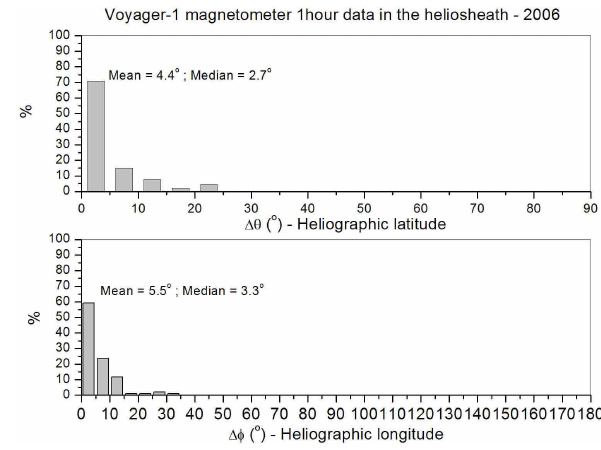
Fig. 14. The angular changes of the magnetic field from magnetic Figure 14 dip to dip in the heliosheath. The angular changes are quite small.